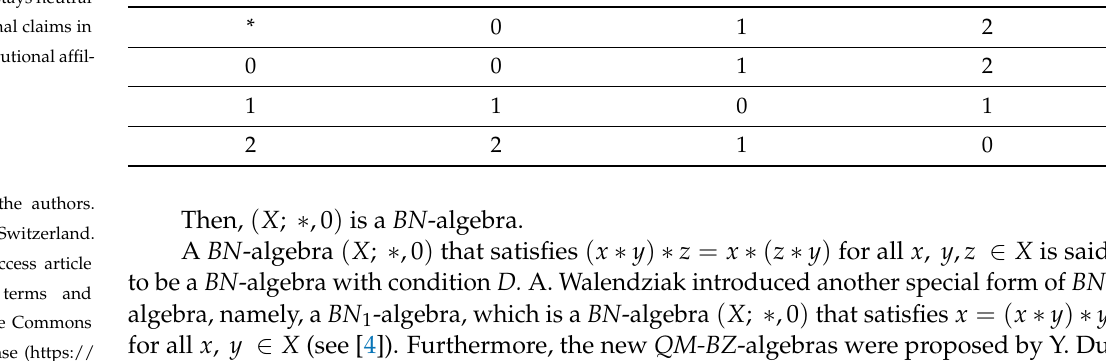
Table 1. Cayley’s table for ( X ; ∗ ,0 )